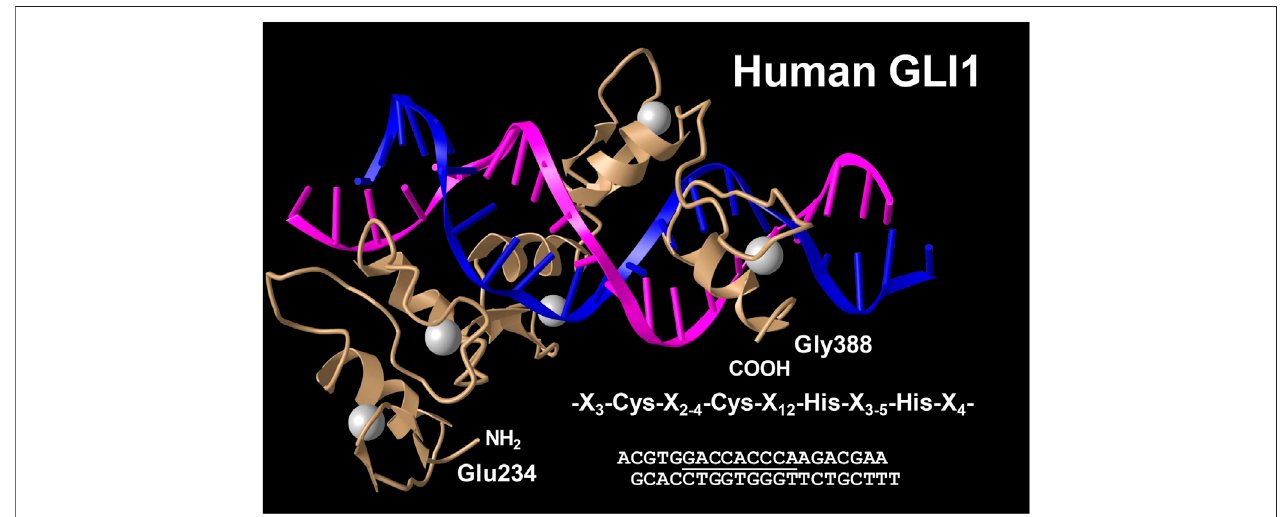
FIGURE9 | Crystal structureof the fi ve Zn fi ngers from humanGLI1 in complexwith ahigh-af fi nity DNA binding site. Shown isa complex ofapeptidederived from the human GLI1 oncoprotein spanning region Glu 234 to Gly388 with a DNA fragment containing the speci fi c binding site 5 ′ -GACCACCCA-3 ′ (underlined). Each of the fi ve zinc fi ngers has a conserved sequence motif that is characterized by the consensus sequence X 3 -Cys-X 2-4 -Cys-X 12 -His-X 3-5 -His-X 4 (where X is any acid residue). The structure has been determined at 2.6 Å resolution. Structure coordinates were taken from the PDB Protein Data Bank (access. no. 2GLI). For details see (Pavletich and Pabo 1993).